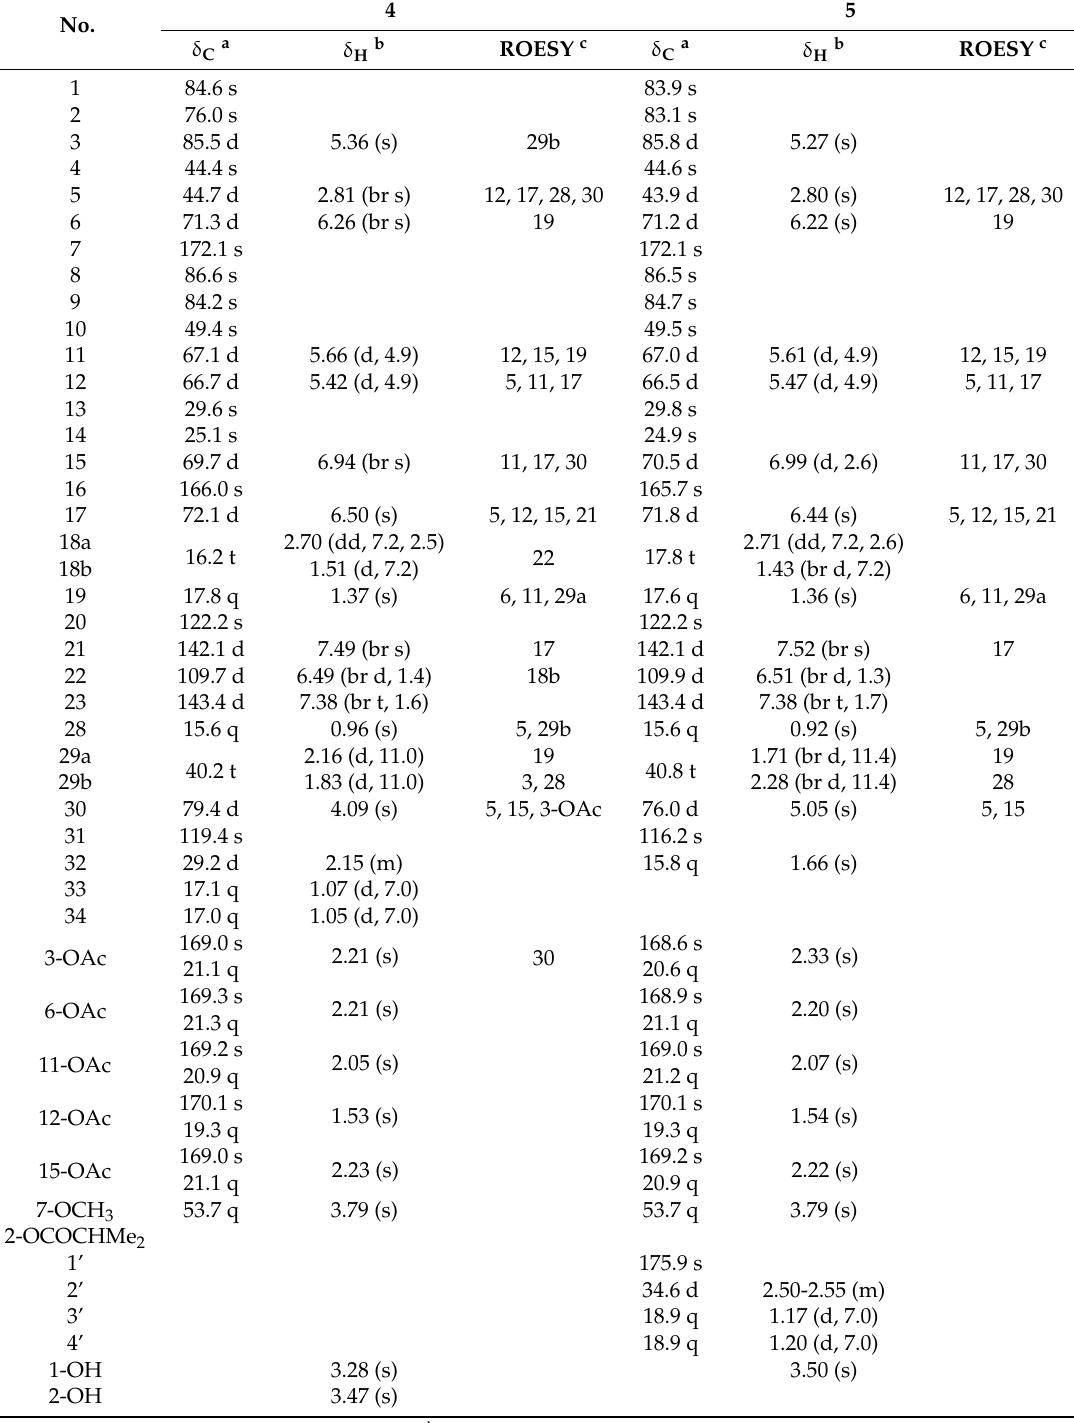
Table 3. NMR spectroscopic data of compounds 4 and 5 in CDCl 3 ( δ in ppm, J in